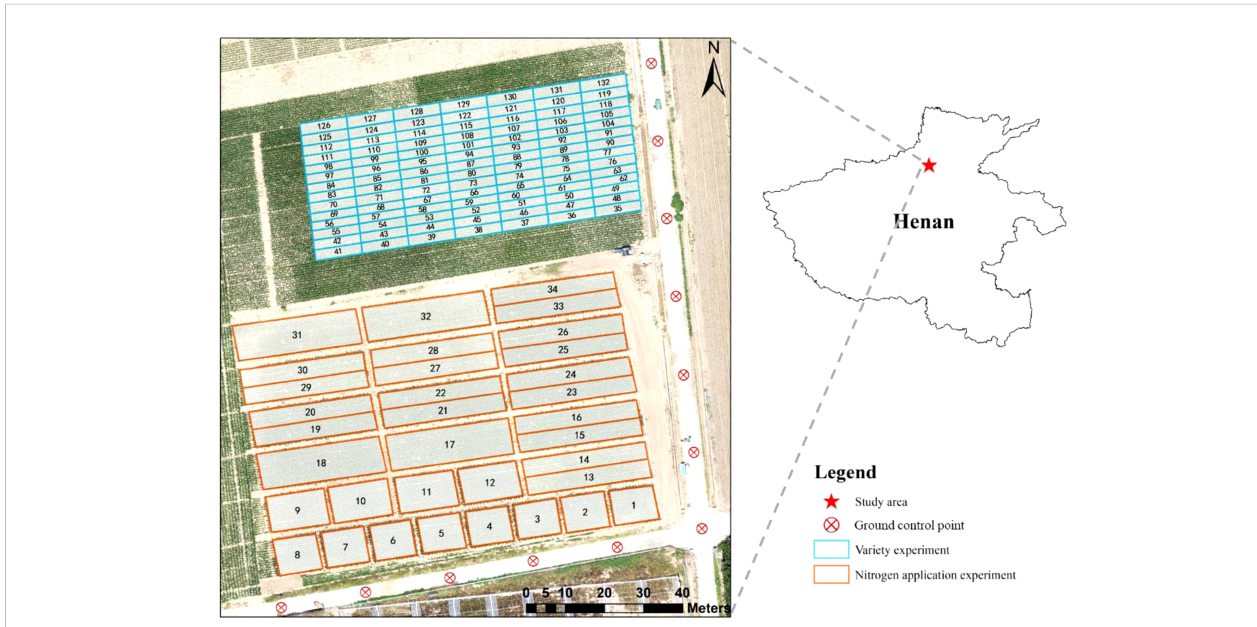
FIGURE 1 Study area location and layout of the experimental